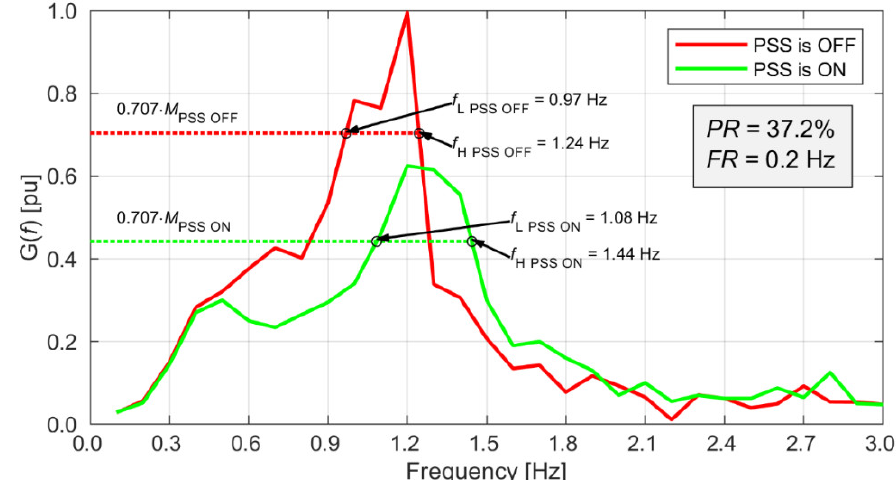
Figure 17. G PSS OFF ( f ) and G PSS ON ( f ), P g = 208 MW, Q g = 0 Mvar [44].